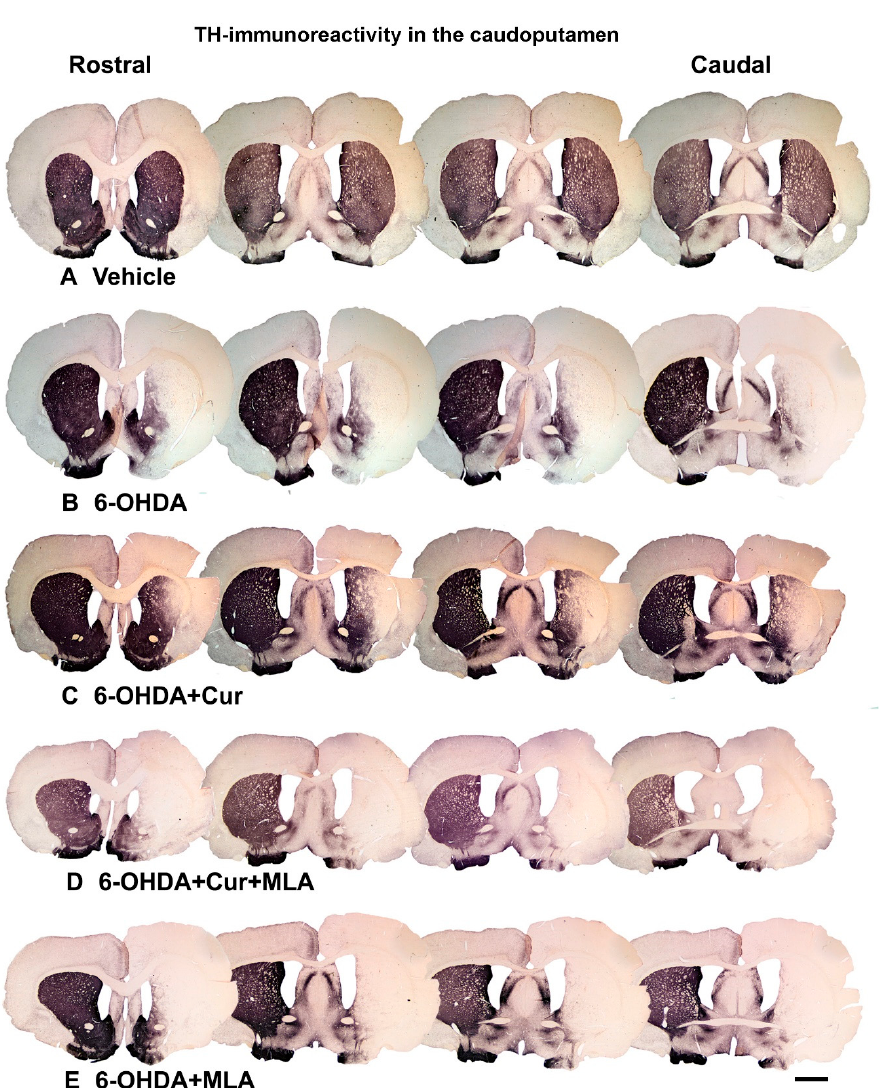
Figure 2. Coronal sections of the brain showing tyrosine hydroxylase (TH)-immunoreactive fibers in four approximately equally spaced rostro-caudal levels in the five animal groups included in the study. The injection of vehicle produced no significant e ff ect on TH immunoreactivities ( A ); In comparison, the intra-striatal 6-OHDA lesion caused extensive reduction in the density of TH-immunoreactive fibers, mainly in the central and lateral parts of head and tail of the caudate-putamen, leaving the medial and ventral sectors partially intact ( B ); Curcumin treatment protected TH-positive fiber innervation to a large extent ( C ); However, 6-OHDA + Cur + MLA treatment reversed the protective e ff ect of curcumin ( D ) but MLA treatment alone showed no significant di ff erence from 6-OHDA or 6-OHDA + Cur + MLA ( E ). Scale bar = 2